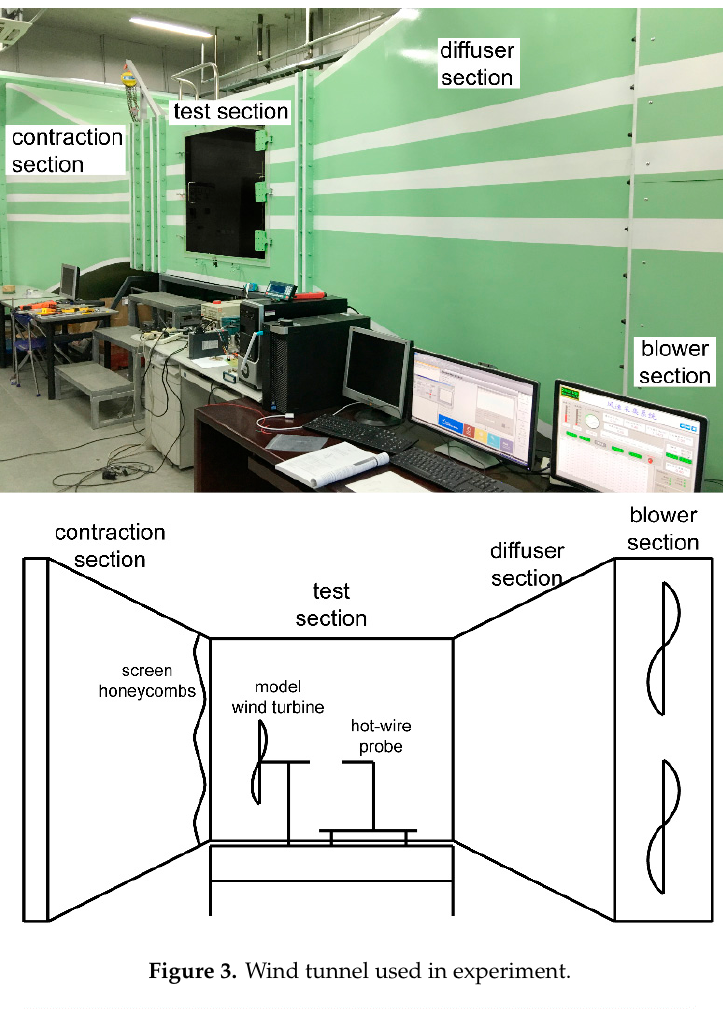
Figure 3. Wind tunnel used in experiment.